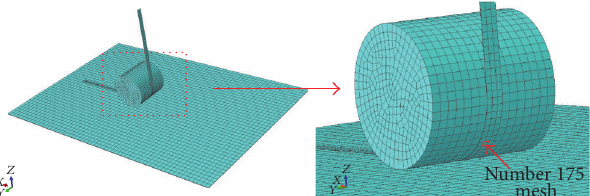
Figure 4: FEM model and position of number 175 mesh in high- speed AFP